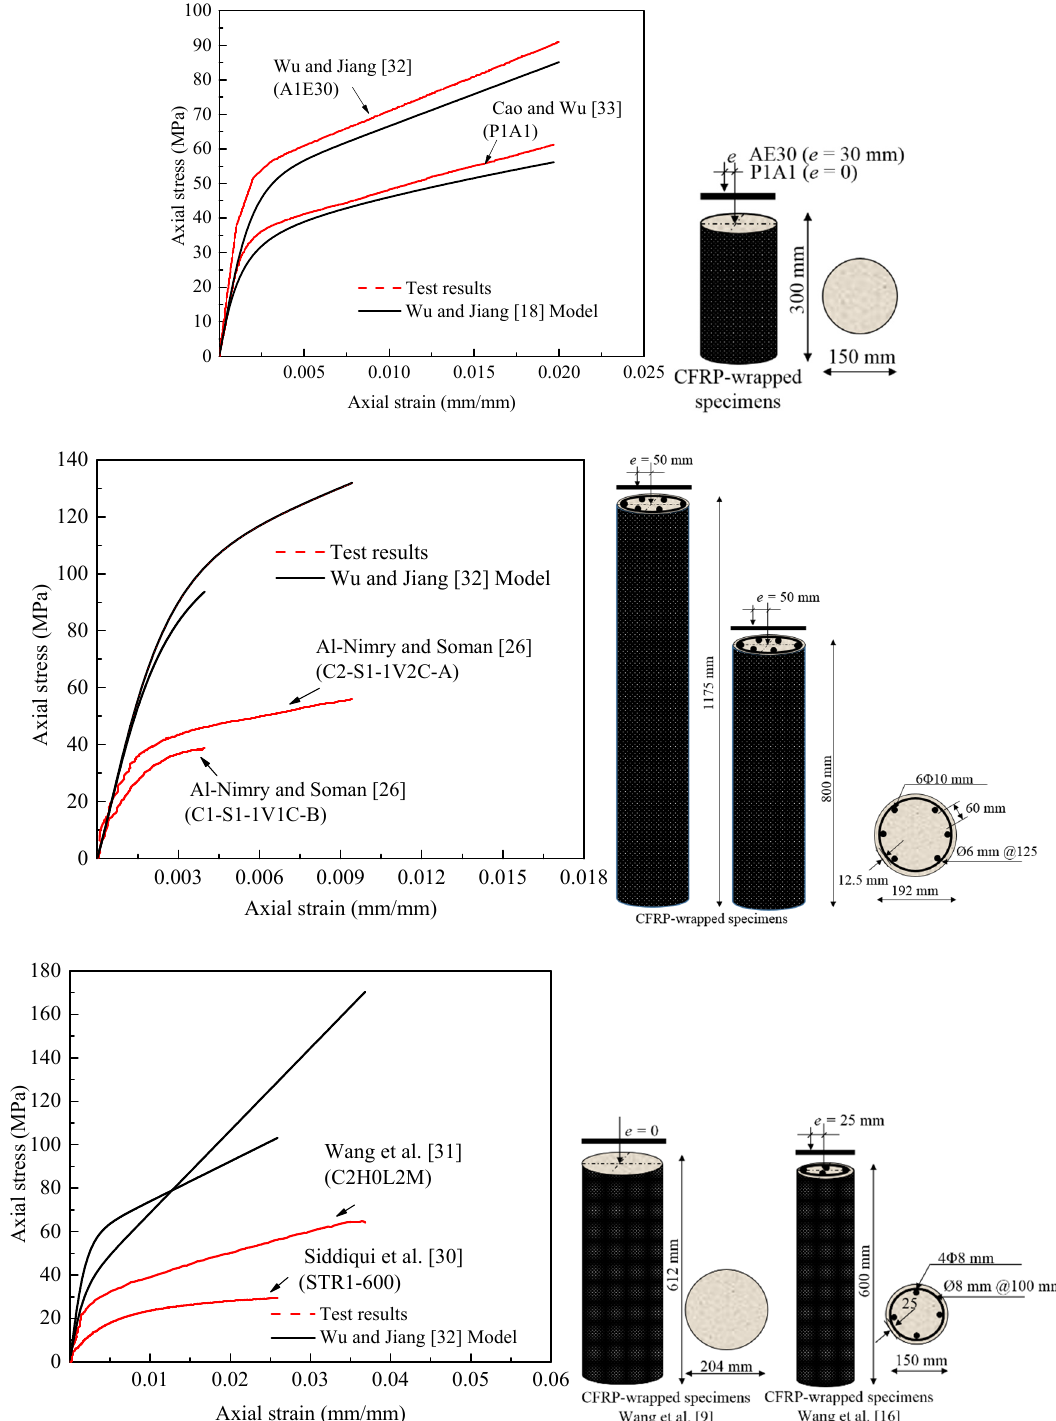
Figure 1. Stress–strain response for FRP-confined columns of small and large scales obtained using Wu and Jiang’s [32] model for FRP-confined concrete cylinders.